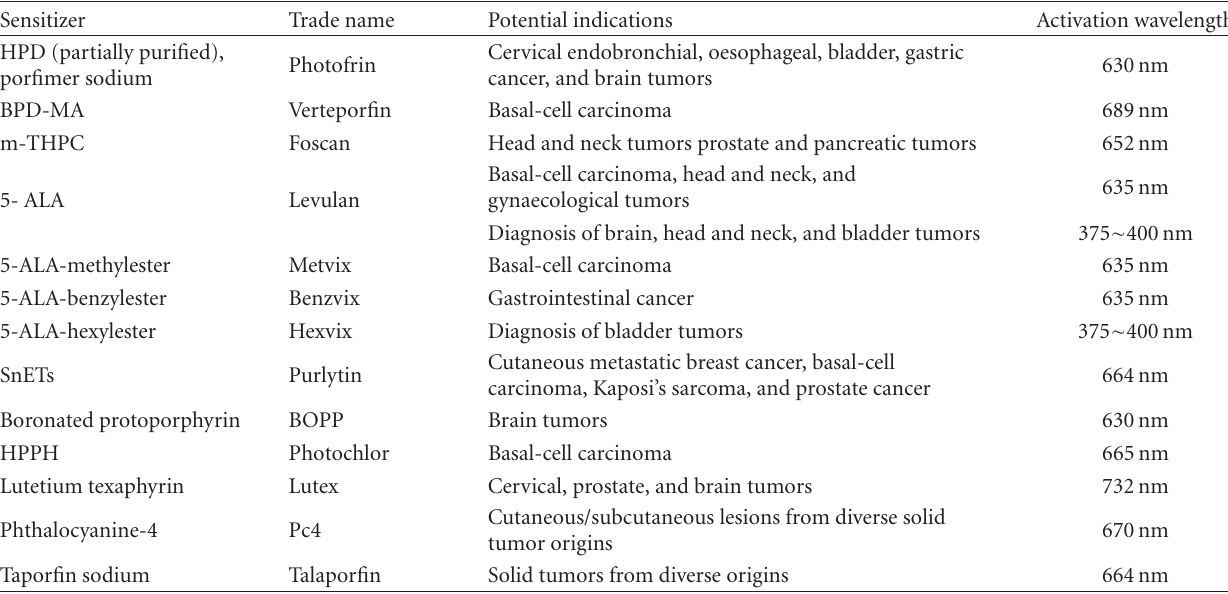
Table 1: Approved or currently on-trial PSs